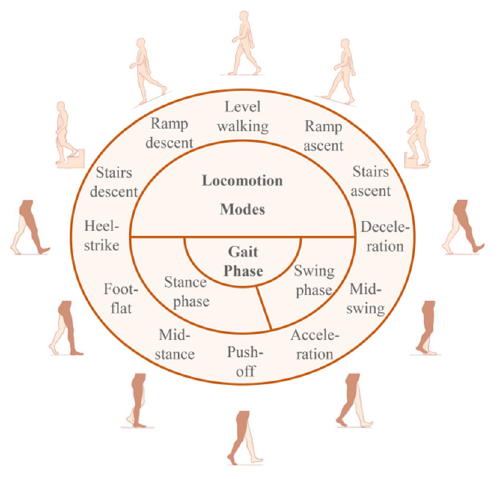
Figure 4. The two commonly studied lower-limb patterns, i.e., locomotion modes and gait phase. Five locomotion modes, along with the definition of the eight-phases gait cycle, are presented here.